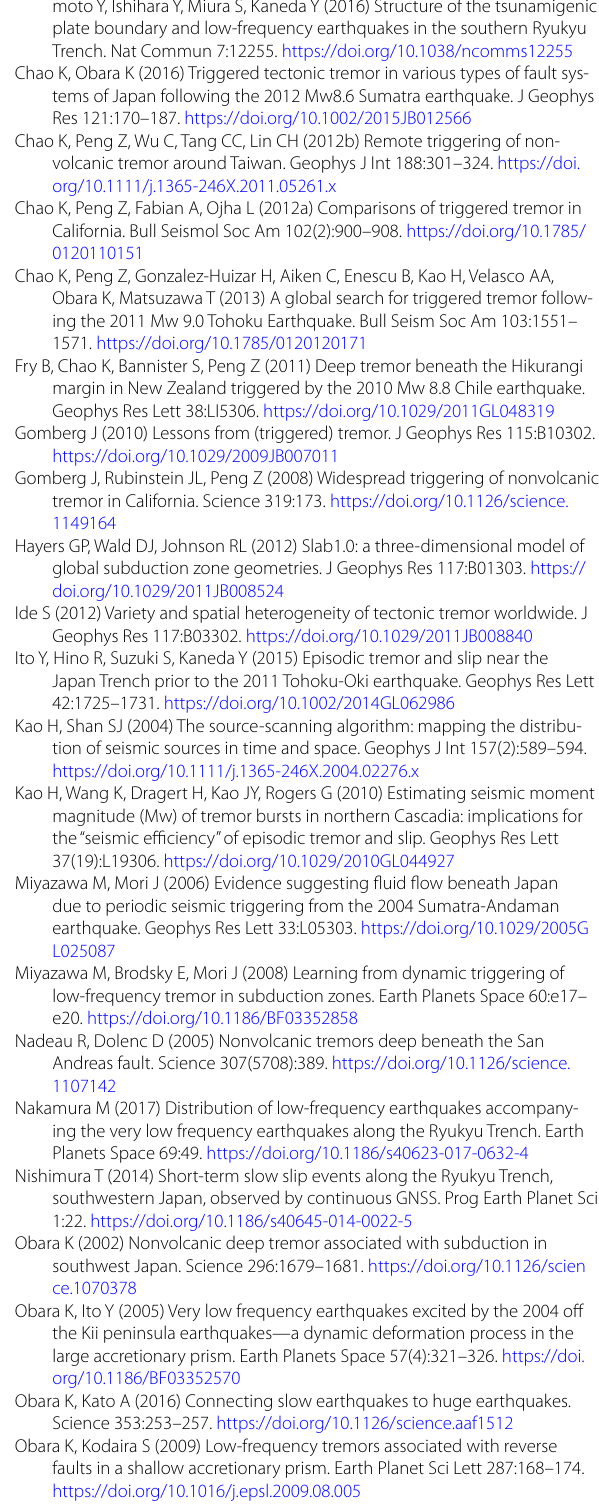
The same as a but 4–8 Hz bandpass-filtered. c The same as a but 8–16 Hz bandpass-filtered. Additional file 4: Figure S2. Waveforms of the triggered LFEs observed in the Yaeyama area. a Broadband and short-period seismographs of the 2005 Nias earthquake. Upper part shows the instrumentally corrected broadband seismograph at IGK. Zero time denotes the occurrence time of the earthquake. The black and white triangles denote the estimated arrival time of the Rayleigh and Love waves, respectively. The velocity of the Rayleigh and Love waves is assumed to be 4.0 km/s and 3.4 km/s, respectively. The thick vertical bar shows the scale of the broadband seismograph. Lower part shows the 2–4 Hz bandpass-filtered short-period seismograph of the N–S component. The triggered LFEs were recorded at several stations. The waveforms are plotted from western stations to east- ern stations along the trench. b The same as a but for the 2008 Wenchuan earthquake. c The same as a but for the 2012 Sumatra earthquake. d The same as a but for the 2015 Nepal earthquake. Additional file 5: Figure S3. Waveforms of the triggered LFEs observed in the Okinawa area. a Broadband and short-period seismographs of the 2005 Nias earthquake. Upper part shows the instrumentally corrected broadband seismograph at ZMM. Zero time denotes the occurrence time of the earthquake. The black and white triangles denote the estimated arrival time of the Rayleigh and Love waves, respectively. The velocity of the Rayleigh and Love waves is assumed to be 4.0 km/s and 3.4 km/s, respectively. The thick vertical bar shows the scale of the broadband seismograph. Lower part shows the 2–4 Hz bandpass-filtered short-period seismograph of the N–S component. The triggered LFEs were recorded at several stations. The waveforms are plotted from southwestern stations to northeastern stations along the trench. a The same as a but for the 2008 Wenchuan earthquake. a The same as a but for the 2012 Sumatra earth- quake. d The same as a but for the 2015 Gorkha